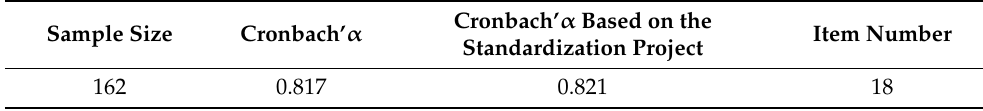
Table 5. Brief table of Cronbach reliability